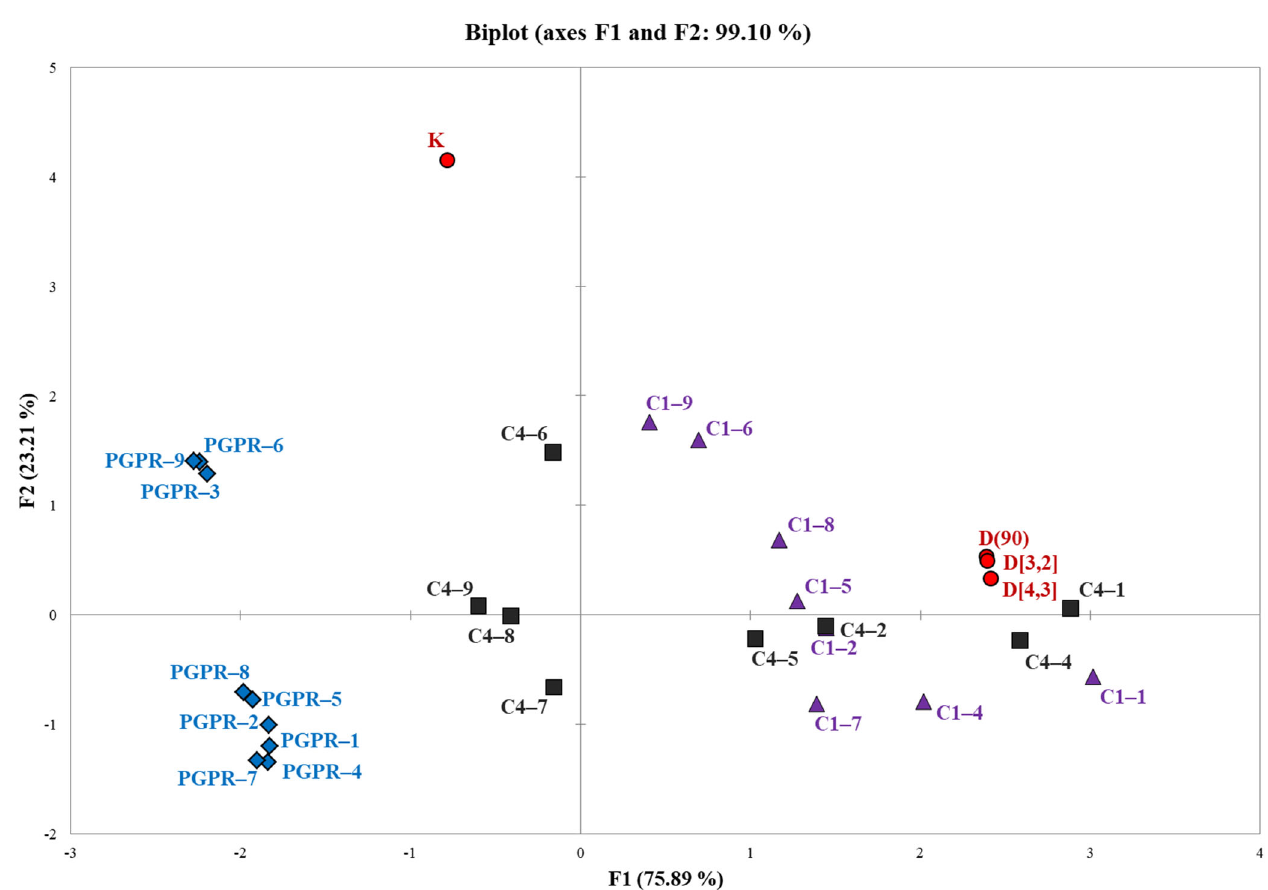
Figure 6. PCA bi-plot diagram for droplet size parameters and consistency coefficient for W/O emul- Figure 6. PCA bi ‐ plot diagram for droplet size parameters and consistency coefficient for W/O sions prepared with different emulsifiers and emulsions prepared with different emulsifiers and formulations.